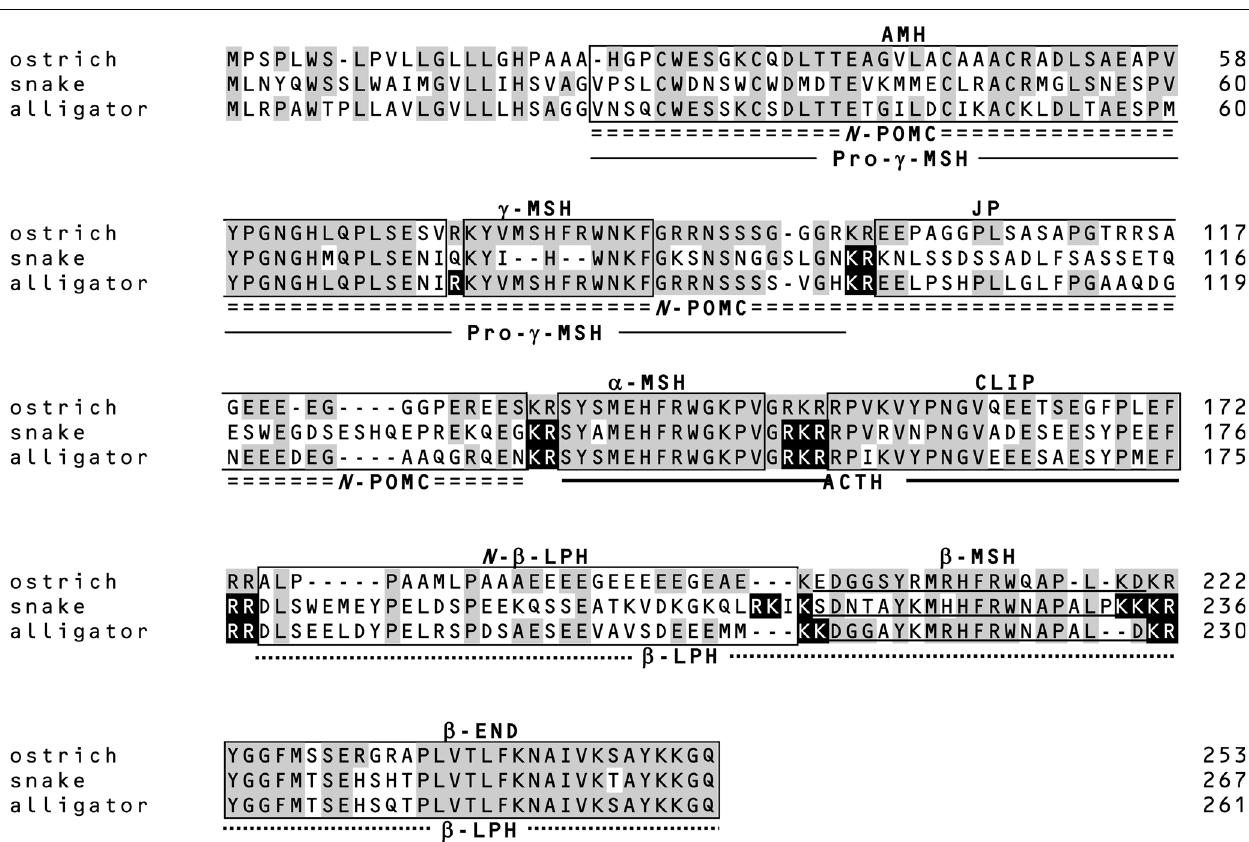
FIGURE 2 |Amino acid sequences of prePOMC from birds and reptiles . Amino acid residues in reptile POMC that are identical to those in ostrich POMC are shaded. Filled amino acid residues indicate the processing sites of